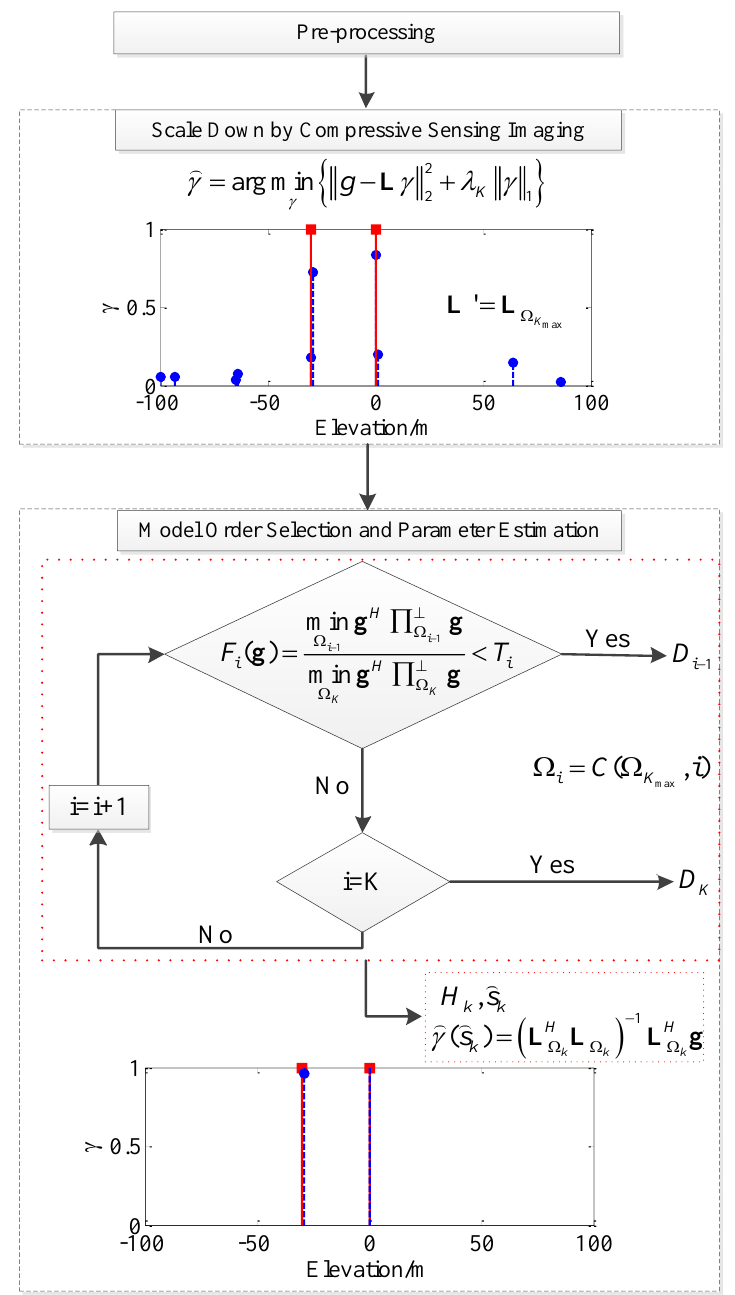
Figure 4. Diagram of the proposed CS-GLRT. Lines in red squares are true reflectivity profiles, and lines in blue dots are the estimated reflectivity profile in each step. There are artifacts for the CS imaging, and magnitudes are underestimated. The artifacts are suppressed and magnitudes are corrected by the GLRT model order selection with negligible elevation